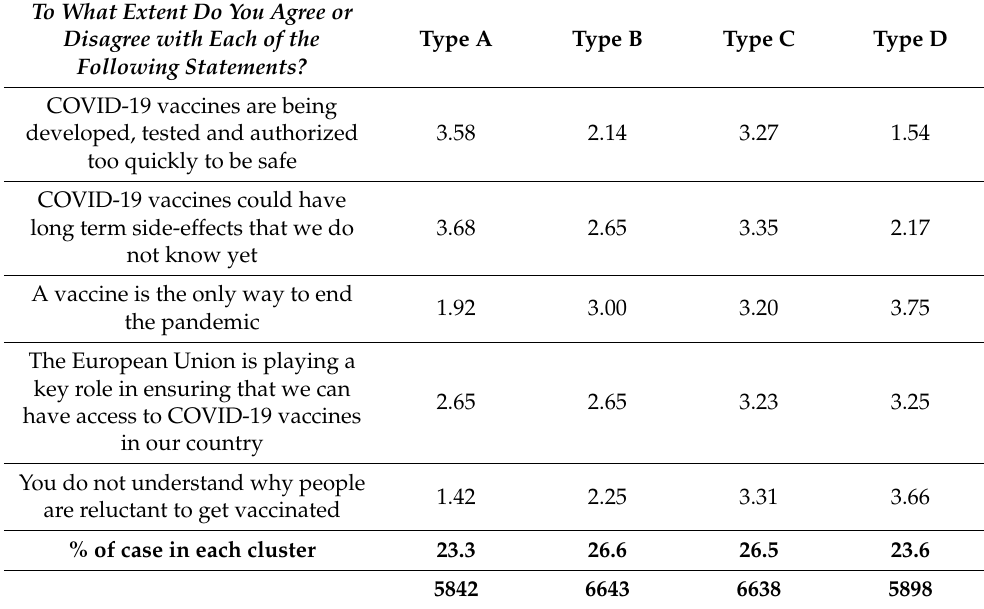
Table 1. K-mean cluster analysis: attitude types towards vaccination against